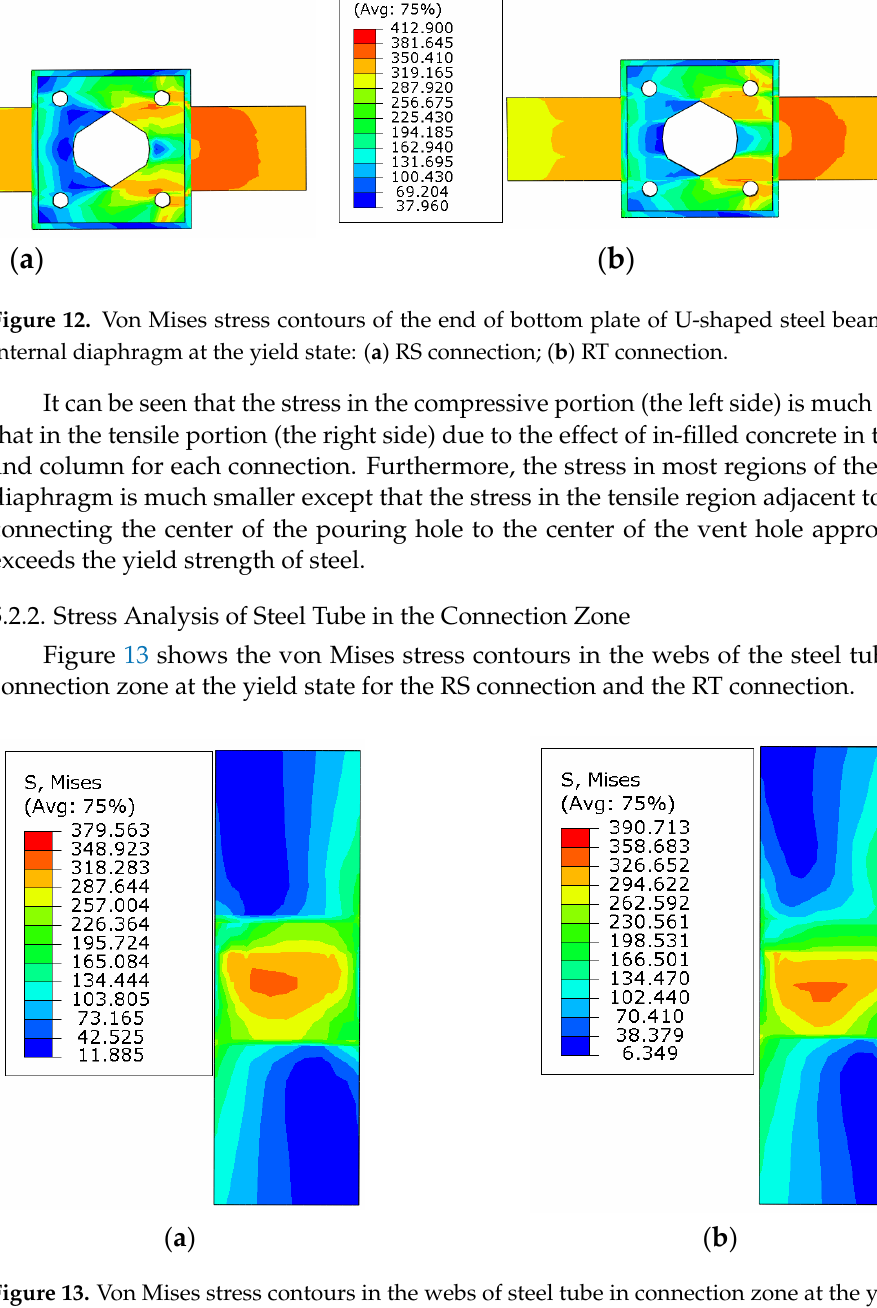
( b ) Figure 14. Von Mises stress contours of the left flange of steel tube in the connection zone: ( a ) RS connection; ( b ) RT connection.